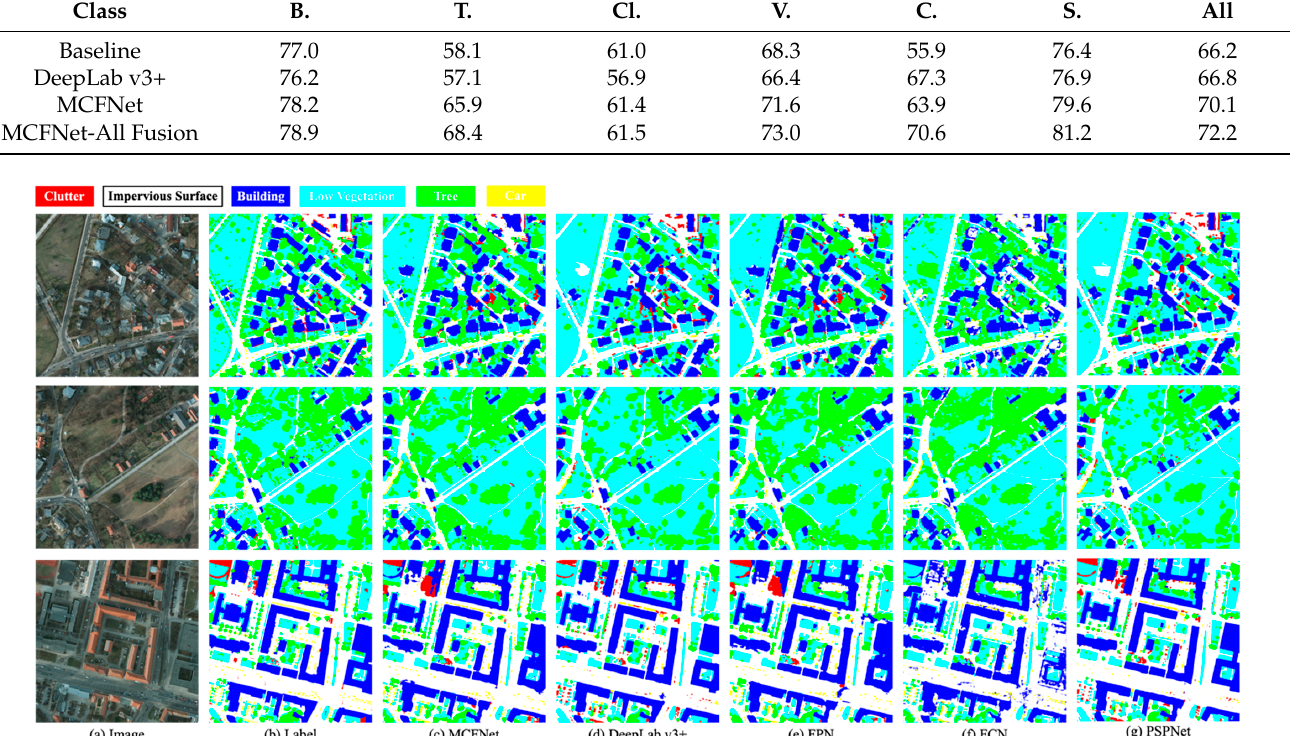
Table 5. Segmentation performance measured in IoU/mIoU(%) on Potsdam.